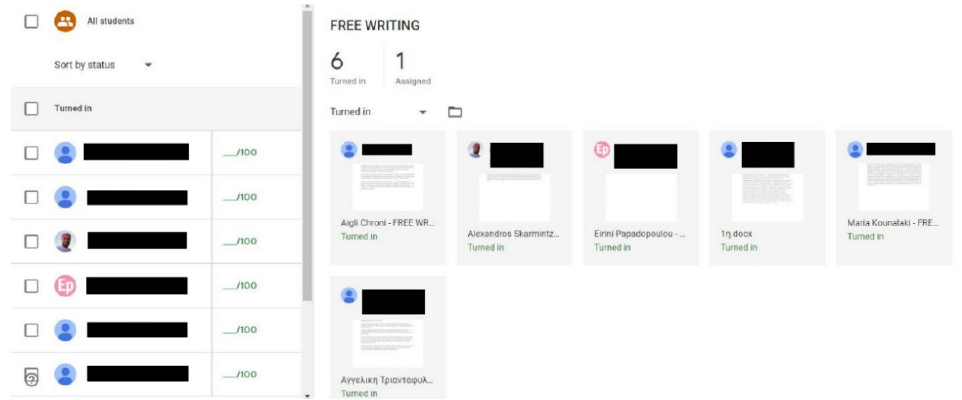
Figure 4. Assignment page.